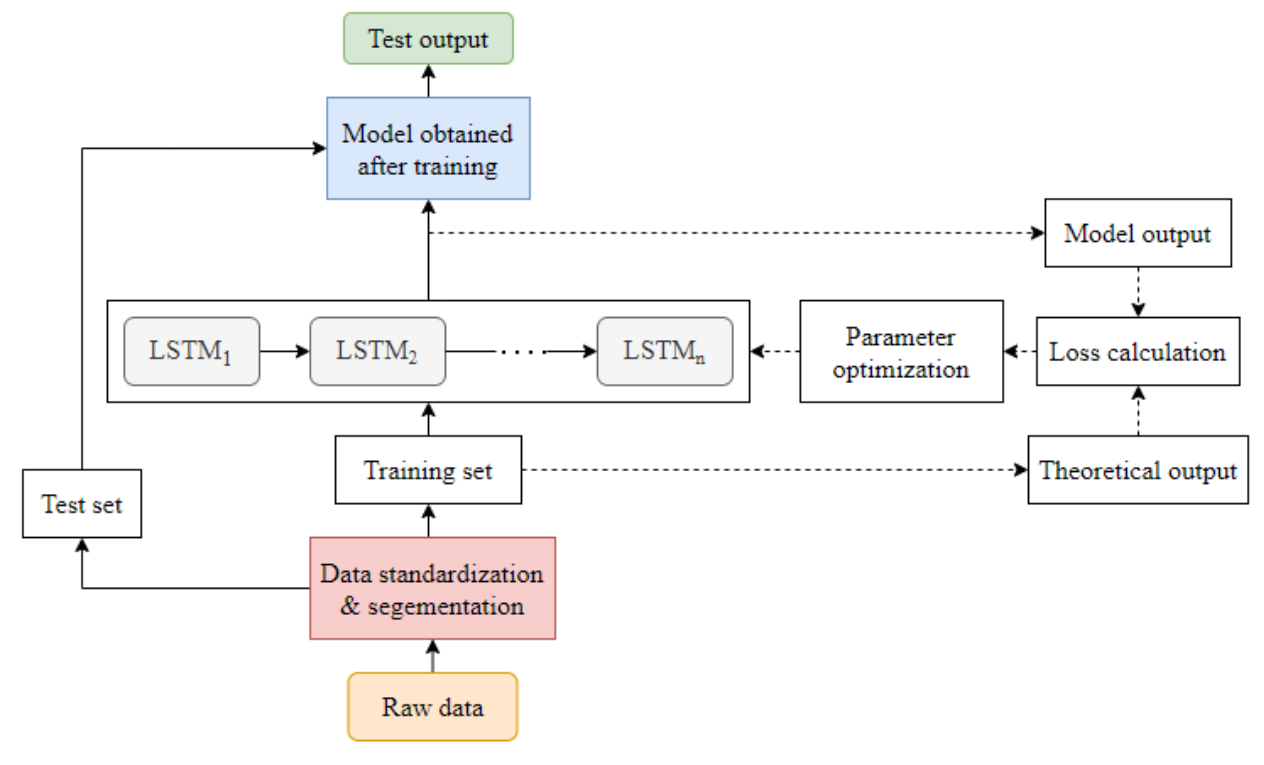
Figure 14. LSTM fault diagnosis framework.